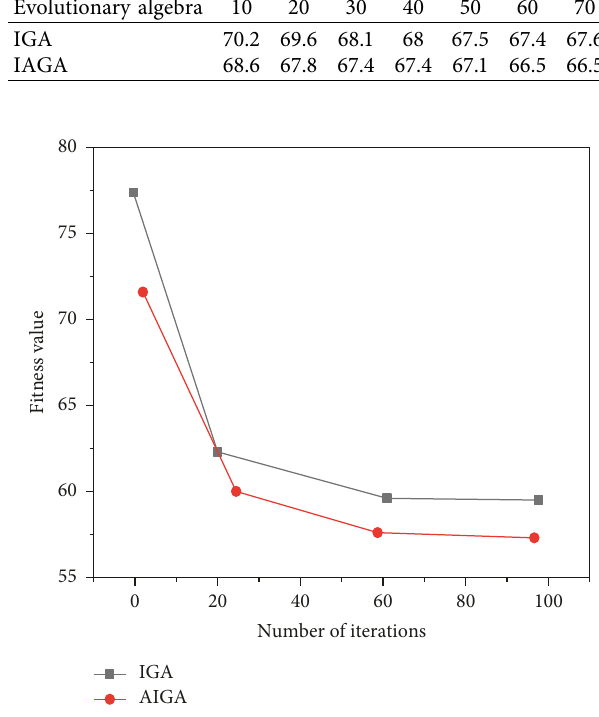
Figure 4: Comparison of IGA and